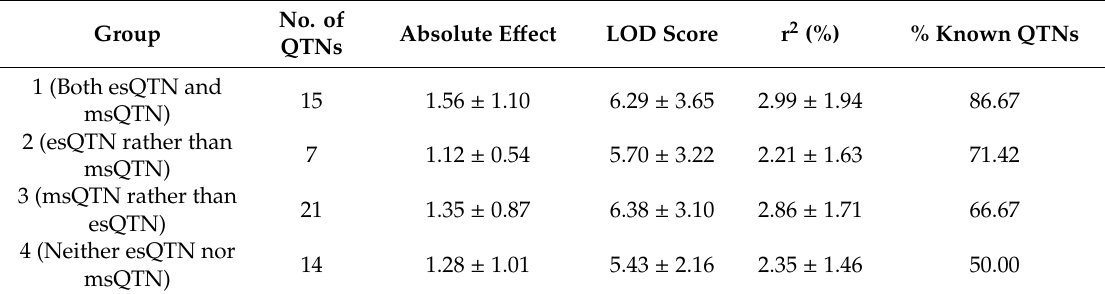
Table 7. Comparison of four kinds of QTNs for soybean 100-seed weight in this study.